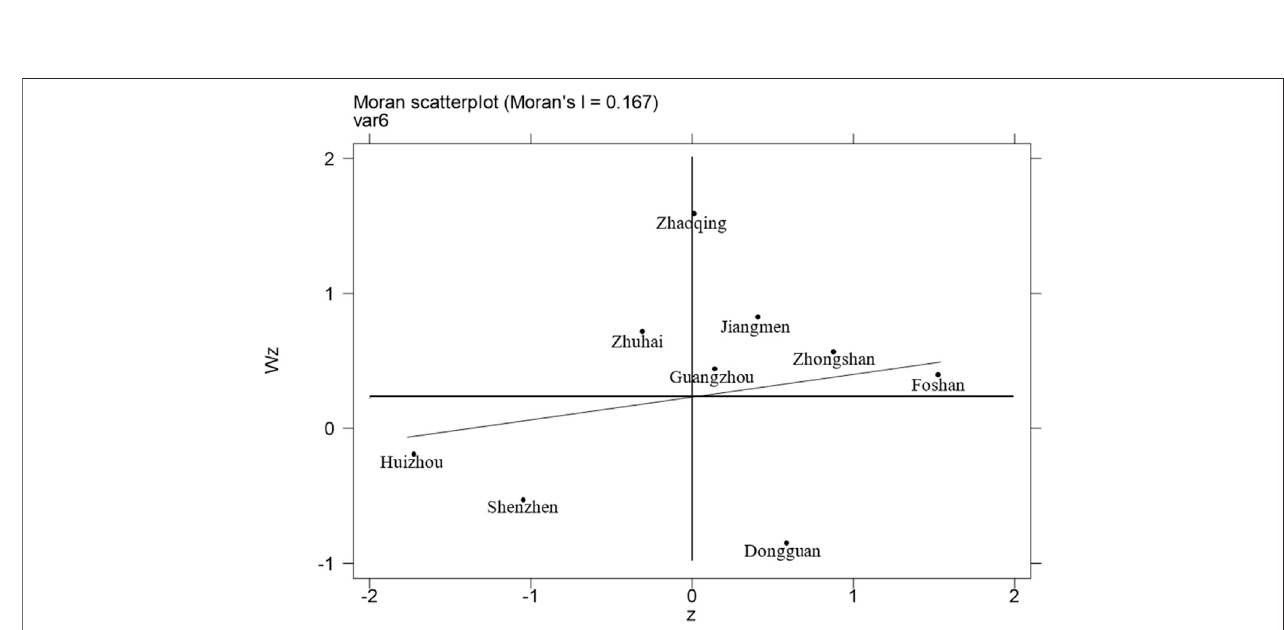
FIGURE 6 | Moran scatter plot of PM 2.5 in the Pearl River Delta region in 2005.